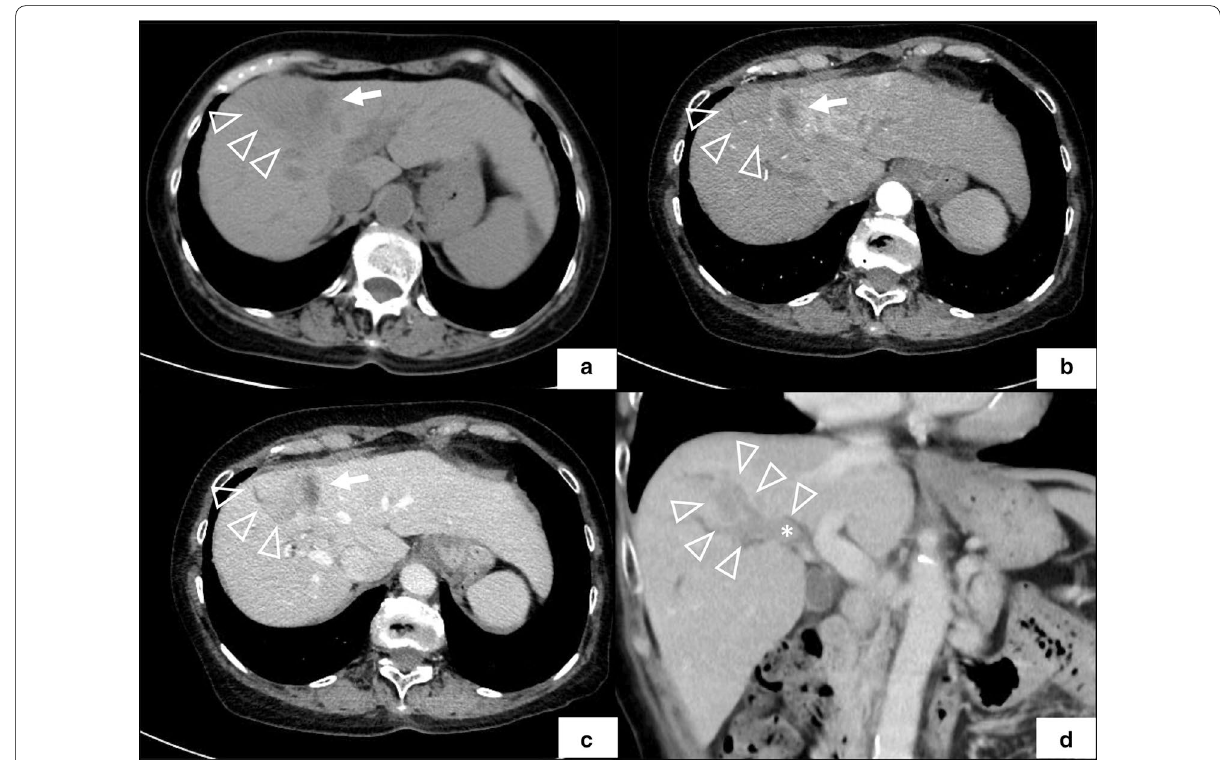
Fig. 1 Preoperative dynamic computed tomography study. a Low-density area (arrow head) located adjacent to the scar of radiofrequency ablation (arrow) in the plain phase. b The image of early phase does not show early staining on the area. c The image of late phase visualized a well-defined mass with enhancement on the area. d The image of multiplanar reconstruction of the tumor (arrow head) with the bile duct thrombus (asterisk). BDTT continued from the tumor into the right hepatic